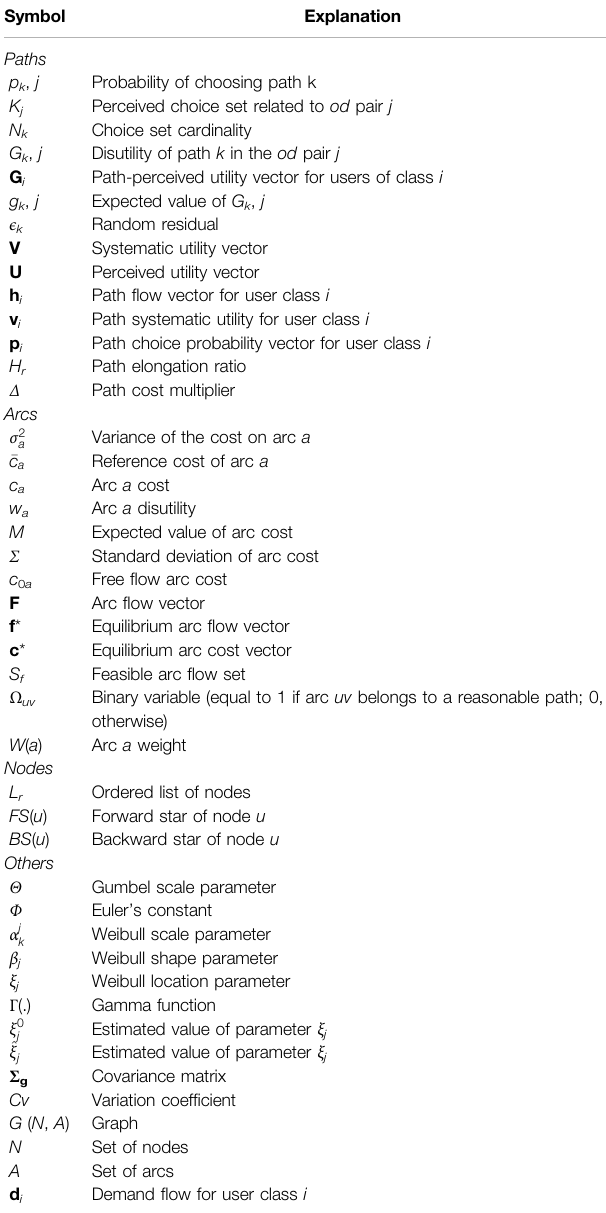
TABLE 1 | Symbols.